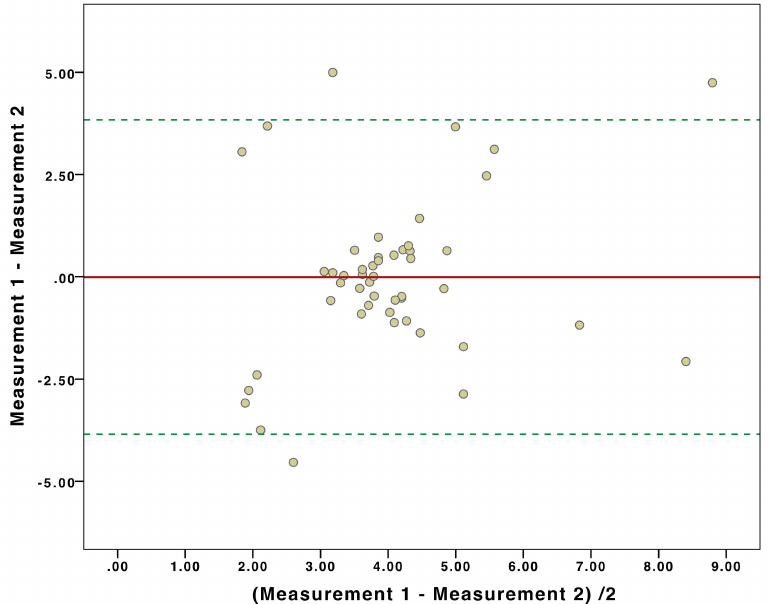
Figure 2. Bland–Altman plot regarding liver sti ff ness measurements by machine 1 and machine 2 on the same patients. The mean di ff erence for liver sti ff ness was − 0.0072, with 95% limits of agreement between − 3.85 and 3.84. It shows no systematic overestimation or underestimation between machine 1 and machine 2.